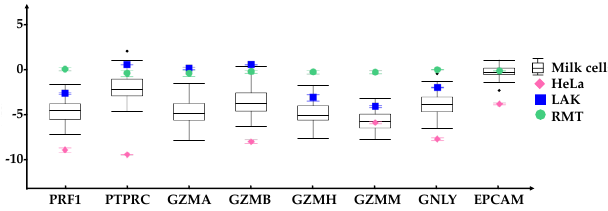
Figure 2. Box and whisker plots of the expression of the immune related genes PRF1, PTPRC, GZMA, GZMB, GZMH, GZMM, GNLY and the epithelial marker EPCAM in 65 HM cell samples ( ). For each gene, the range of expression is shown by the whiskers of the plot and the interquartile ranges are displayed as the upper and lower sections of the boxes. The median expression in milk cells for each gene is represented by the horizontal line going through the box. In the case of milk cell outliers, these are represented by black circles. HeLa cells ( ) were used as a negative control whereas Lymphokine Activated Killer cells (LAK, ) were a positive control for immune markers. All genes were normalized to resting mammary tissue (RMT, ). The measured standard error of the mean for these reference samples are represented by error bars. All immune related genes were expressed in the HM cells, although in some cases having a lower expression compared to RMT and LAK.